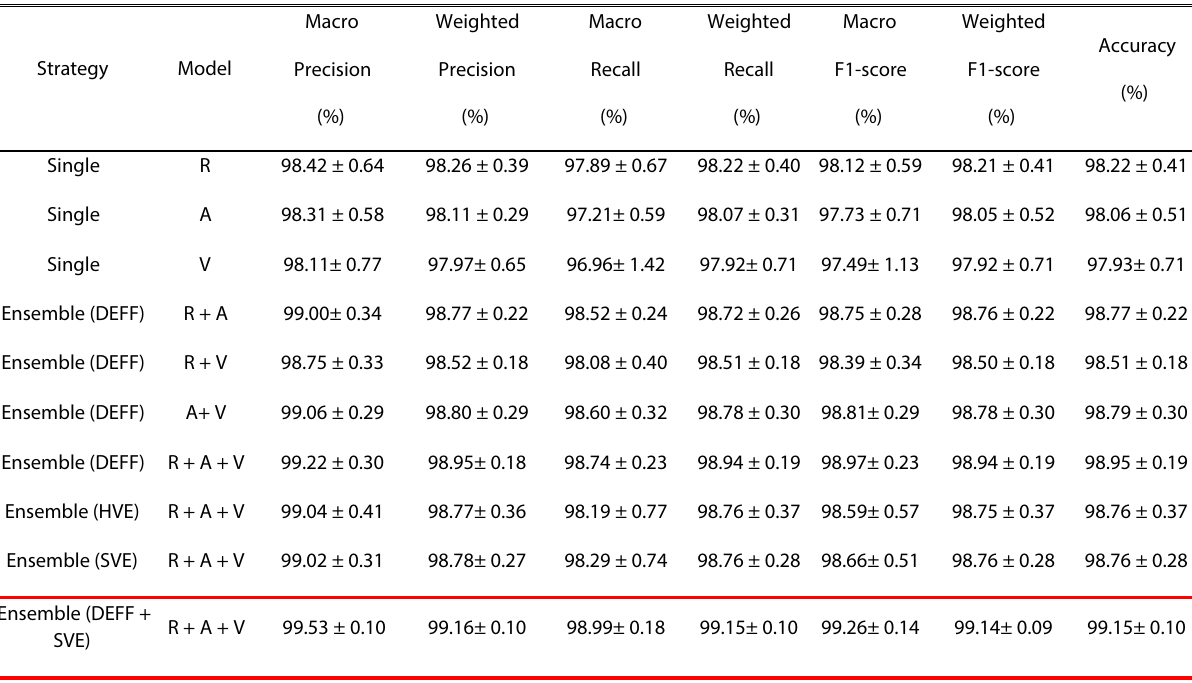
Table 2. Classification performance (mean and SD) using different strategies from 20 independent runs. Three CNNs including ResNet18 (R), AlexNet (A), and VGG16 (V) are applied. The Highest Performance Values are Highlighted in the red box in the